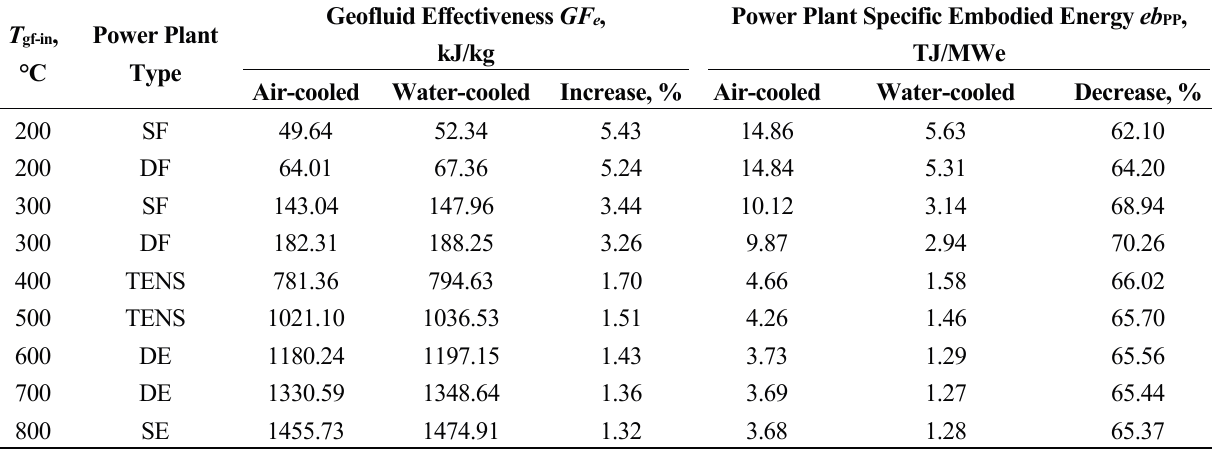
Table 7. Comparison of the air-cooled and water-cooled power plants.